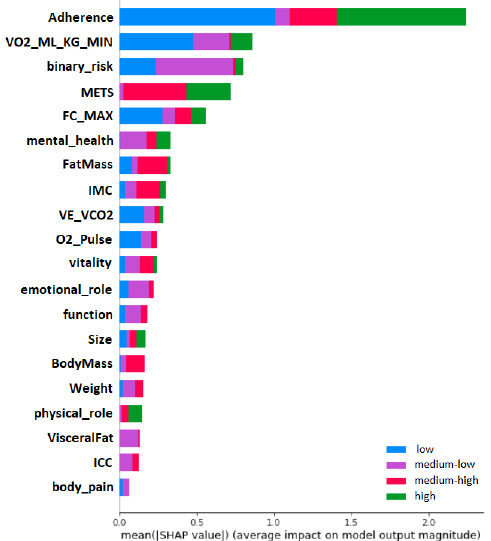
Figure 6. Global impact of the variables on the cardiovascular risk model. It can be observed that adherence, oxygen uptake and MET have a major impact on the prediction, allowing to reduce the cardiovascular risk.